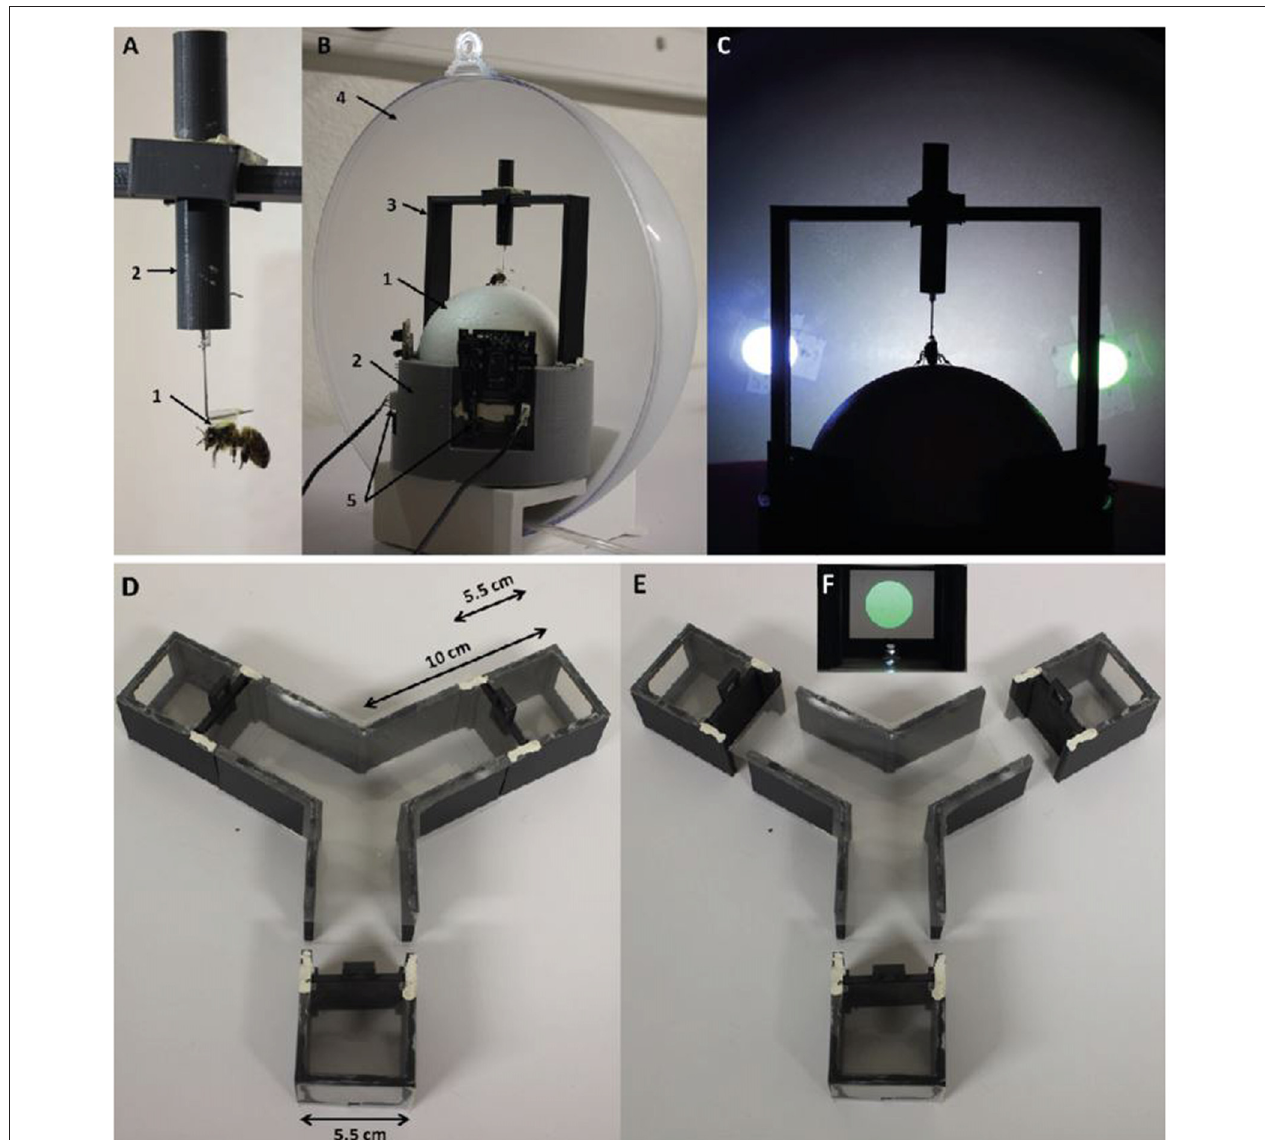
FIGURE 1 | Experimental setups. The virtual reality (VR) setup (A–C) and the Y-maze (D–F) . (A) A bee tethered by the thorax by means of a vertical attachment (1) made of a custom-built tag (1) and an L-shaped metal piece glued to the thorax. The metal piece was enclosed in a plastic cylinder (2), which allowed its vertical displacement and thus the accommodation of the bee on the surface of the treadmill (2). (B) Global view of the VR system. The polystyrene ball (1) floated on a constant airflow provided at the basis of a ball support (2). The tethered bee was placed on the ball thanks to a holding support (3). The apparatus is placed behind a semi-spherical opaque screen (4) on which visual stimuli were projected. Two optic-mouse sensors (5) were placed on the ball support, at 90 ◦ of each other to record the ball movements. The setup translates the movements of the walking bee into rotations of the ball. (C) Front view of the setup during a conditioning trial. The tethered bee walking stationary faced the two-colored discs presented at − 45 ◦ and +45 ◦ of its longitudinal axis. (D) Top view of the Y-maze. Each arm was connected to a removable box with a sliding door, which allowed displacing an enclosed bee from an arm to another. Arms were 10 cm in length, 4 cm in height and 5.5 cm in width. Each box had a length of 5.5 cm. (E) Top view of the maze showing the disconnected boxes and how they could be interchanged between arms of the maze. (F) Front view of the inside of a box. A color disc was projected by the video projector onto the article screen placed at the end of each box.